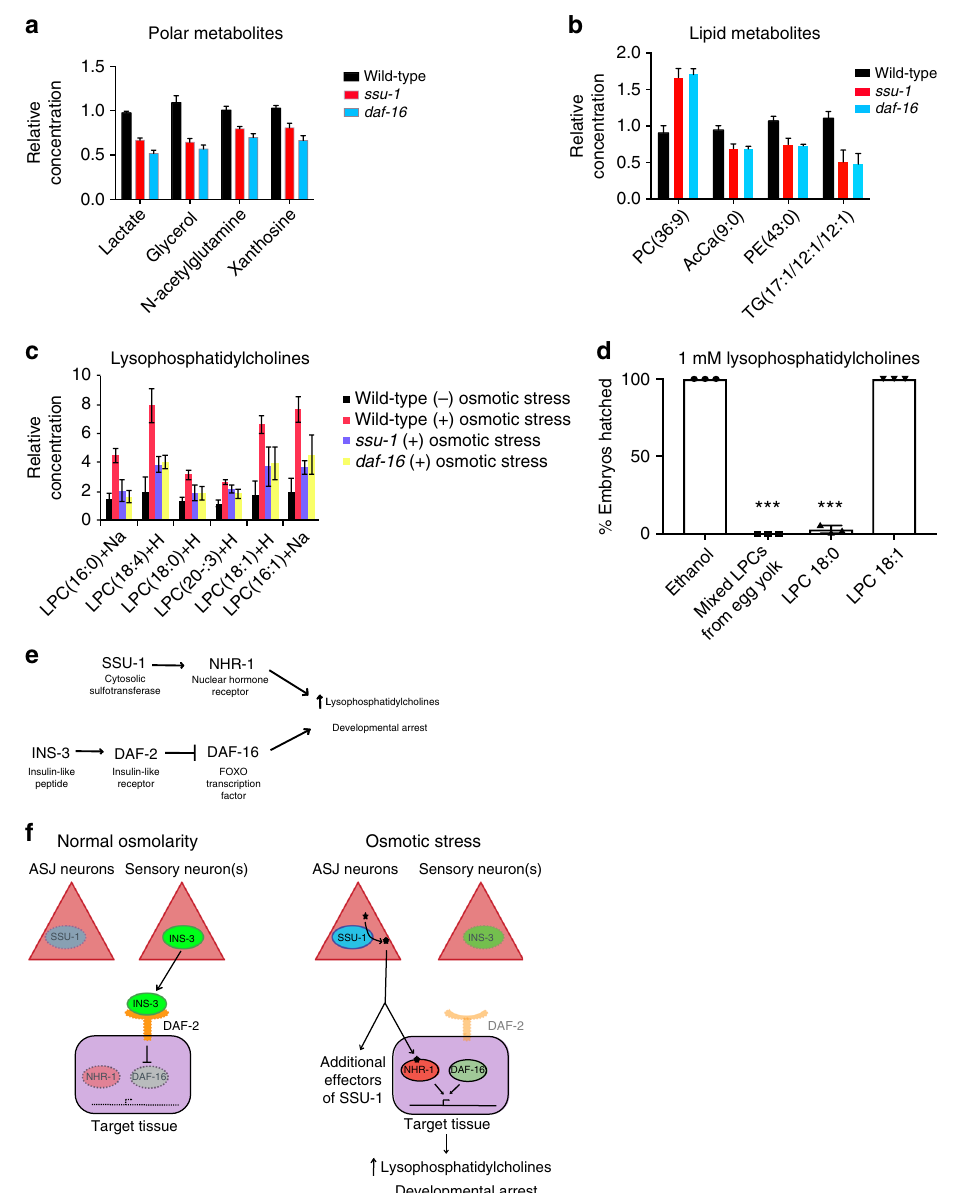
Fig. 4 SSU-1 and DAF-16 regulate lysophosphatidylcholine levels in response to osmotic stress. a Relative levels of polar metabolites exhibiting a statistically signi fi cant ( p < 0.01) change in levels in ssu-1(fc73) and daf-16(m26) mutant embryos. Metabolites were normalized to the levels of histidine. n = 3 replicates. Error bars, s.d. b Relative levels of lipid metabolites exhibiting a statistically signi fi cant ( p < 0.01 two-tailed t -test) change in levels in both ssu-1(fc73) and daf-16(m26) mutant embryos. Metabolites were normalized to the levels of total lipid. n = 3 replicates. Error bars, s.d. PC phosphatidylcholine, AcCa acylcarnitine, PE phosphatidylethanolamine, TG triglyceride. c Relative levels of lysophosphatidylcholine (LPC) metabolites in the wild-type and ssu-1(fc73) and daf-16(m26) mutant embryos. Metabolites shown exhibited a statistically signi fi cant ( p < 0.01 two-tailed t -test) and greater than twofold increase in abundance in response to osmotic stress (300 mM NaCl) and required both SSU-1 and DAF-16. Metabolites were normalized to the levels of total lipid. n = 3 replicates. Error bars, s.d. d Percent of wild-type embryos from parents fed 1 mM lysophosphatidylcholines (LPCs) that hatch. Error bars, s.d. e Diagram of the genetic pathway regulating C. elegans development in response to osmotic stress. This diagram is based on the results described here and the insulin-like signaling pathway regulating developmental arrest in response to osmotic stress described previously by Burton et al. 5 . f Model for how C. elegans regulates development in response to osmotic stress. This model is based on the results described here and the results described previously by Burton et al . 5 Source data are provided as a Source Data fi le